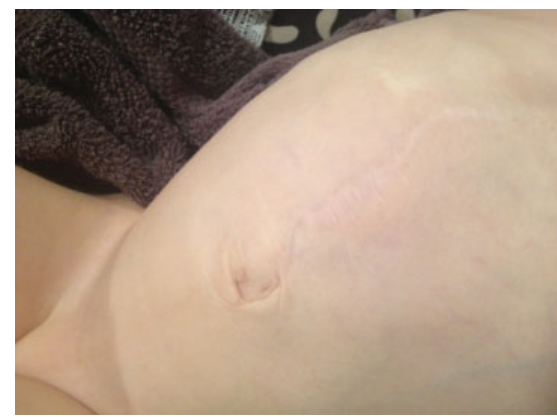
Fig. 2 Cosmetic result after 6 months of the abdominal wall